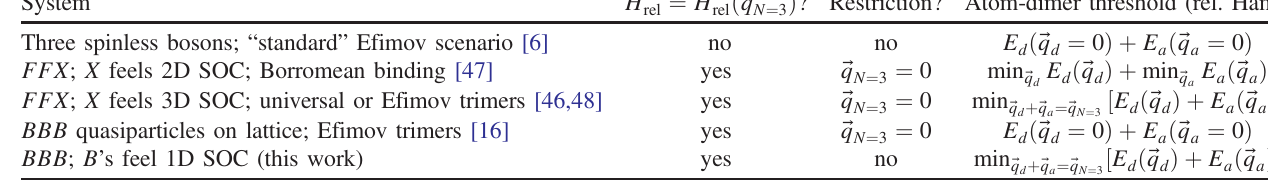
TABLE I. Summary of three-particle studies. The standard Efimov scenario (first row) is contrasted with three-particle systems for which the relative Hamiltonian The last column lists the atom-dimer threshold of the relative Hamiltonian. The symbols E dimer, energy of the atom, generalized momentum of the dimer, and generalized momentum of the atom, respectively. SOC, spin-orbit coupling; F , fermion; X , a particle different from F ; B , boson.